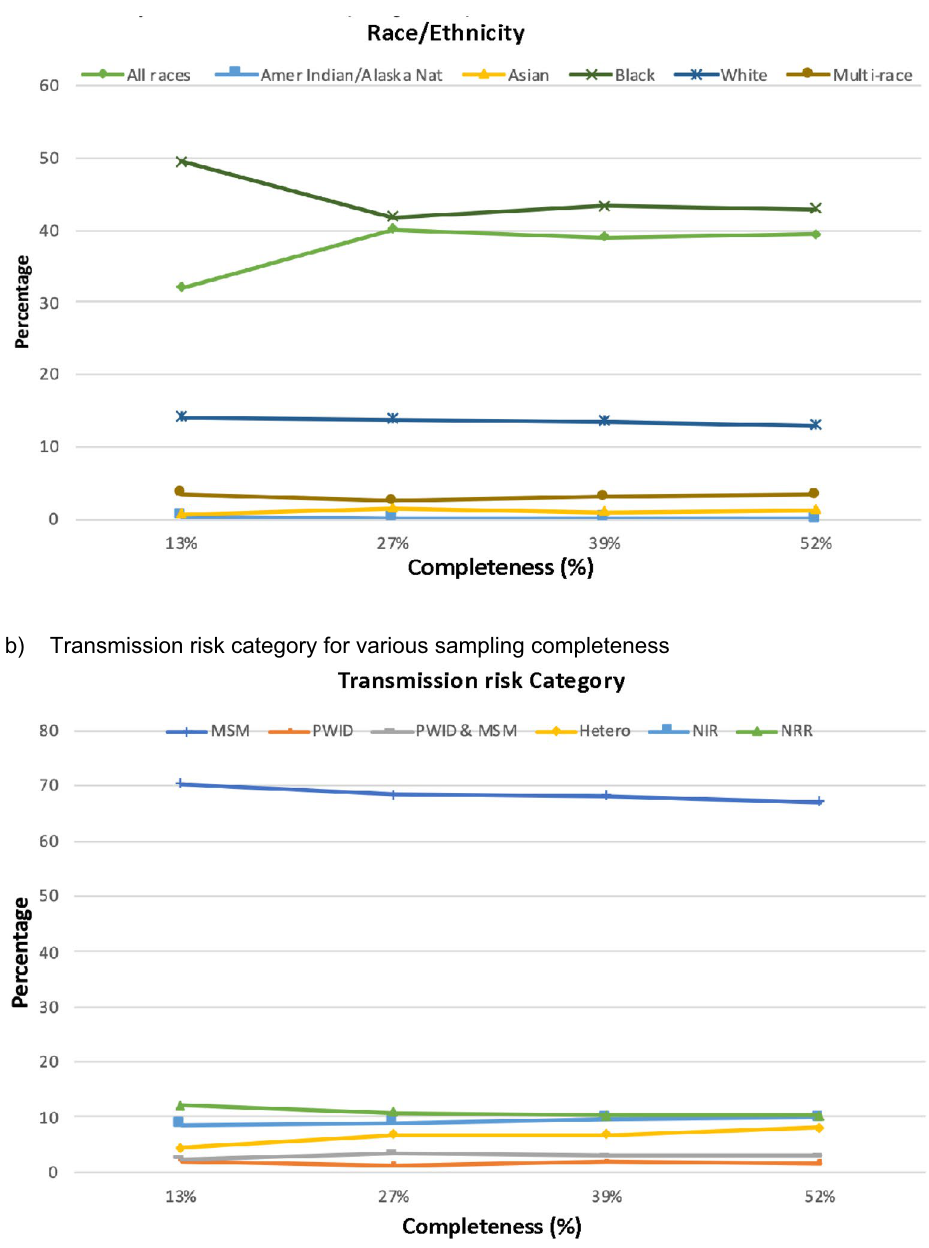
Figure 3. The distribution of clustered nodes in three demographic categories and transmission risk for full versus artificially subsampled data: ( a ) race/ethnicity, ( b ) transmission risk category, ( c ) sex (assigned at birth) and ( d )